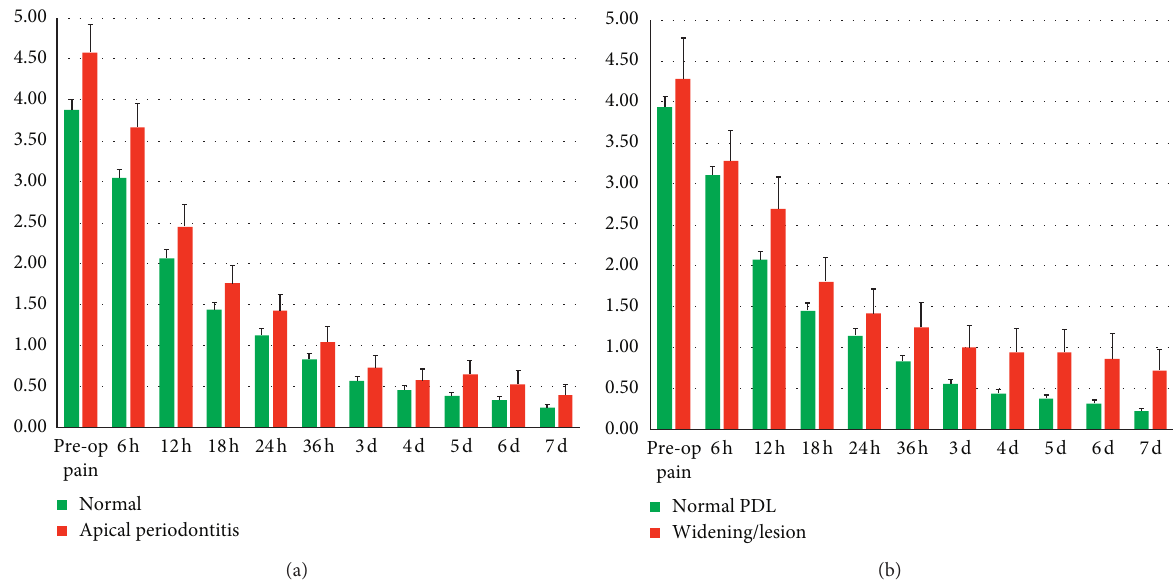
Figure 4: Pain intensity changes in presence or absence of (a) apical periodontitis or (b) PDL